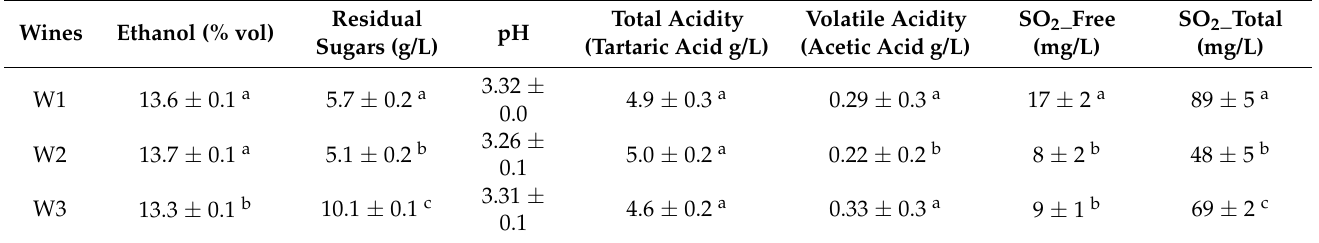
Table 1. Enological parameters 1 of the Savvatiano wines fermented with S. cerevisiae (W1), with M.